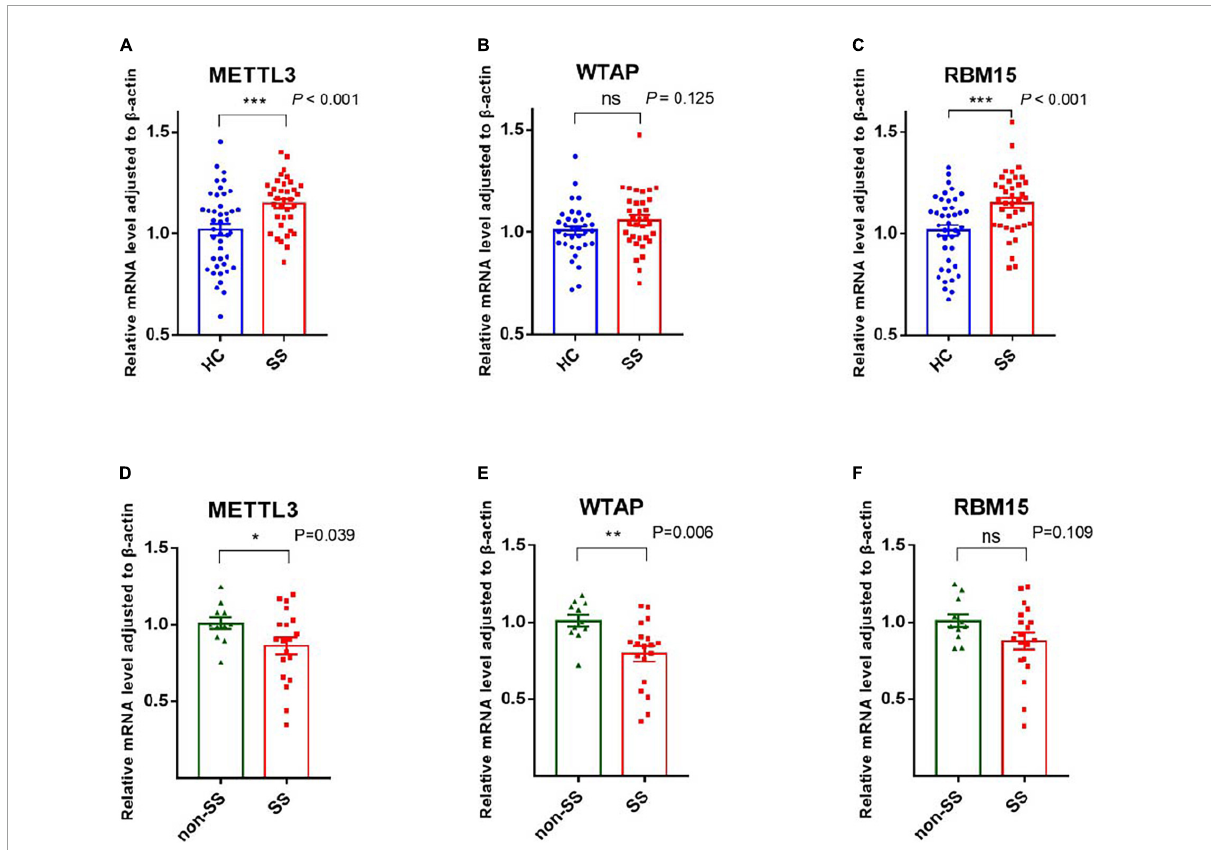
FIGURE1 Messenger RNA (mRNA) levels of N6-methyladenosine (m6A) writers in peripheral blood mononuclear cells (PBMCs) from patients with primary Sjögren’s syndrome (pSS), patients with non-SS sicca, and healthy controls (HCs). (A,D) The mRNA level of METTL3 in PBMCs from patients with pSS was higher than that of HCs but lower than that of patients with non-SS sicca. (B,E) No significant difference was found in the expression of WTAP between patients with pSS and HCs. When compared to patients with non-SS sicca, the mRNA level of WTAP was decreased in patients with pSS. (C,F) The mRNA level of RBM15 in PBMCs from patients with pSS was higher than HCs. No significant difference was found in the expression of RBM15 between patients with pSS and patients with non-SS sicca. * p < 0.05, ** p < 0.01, and *** p < 0.001.